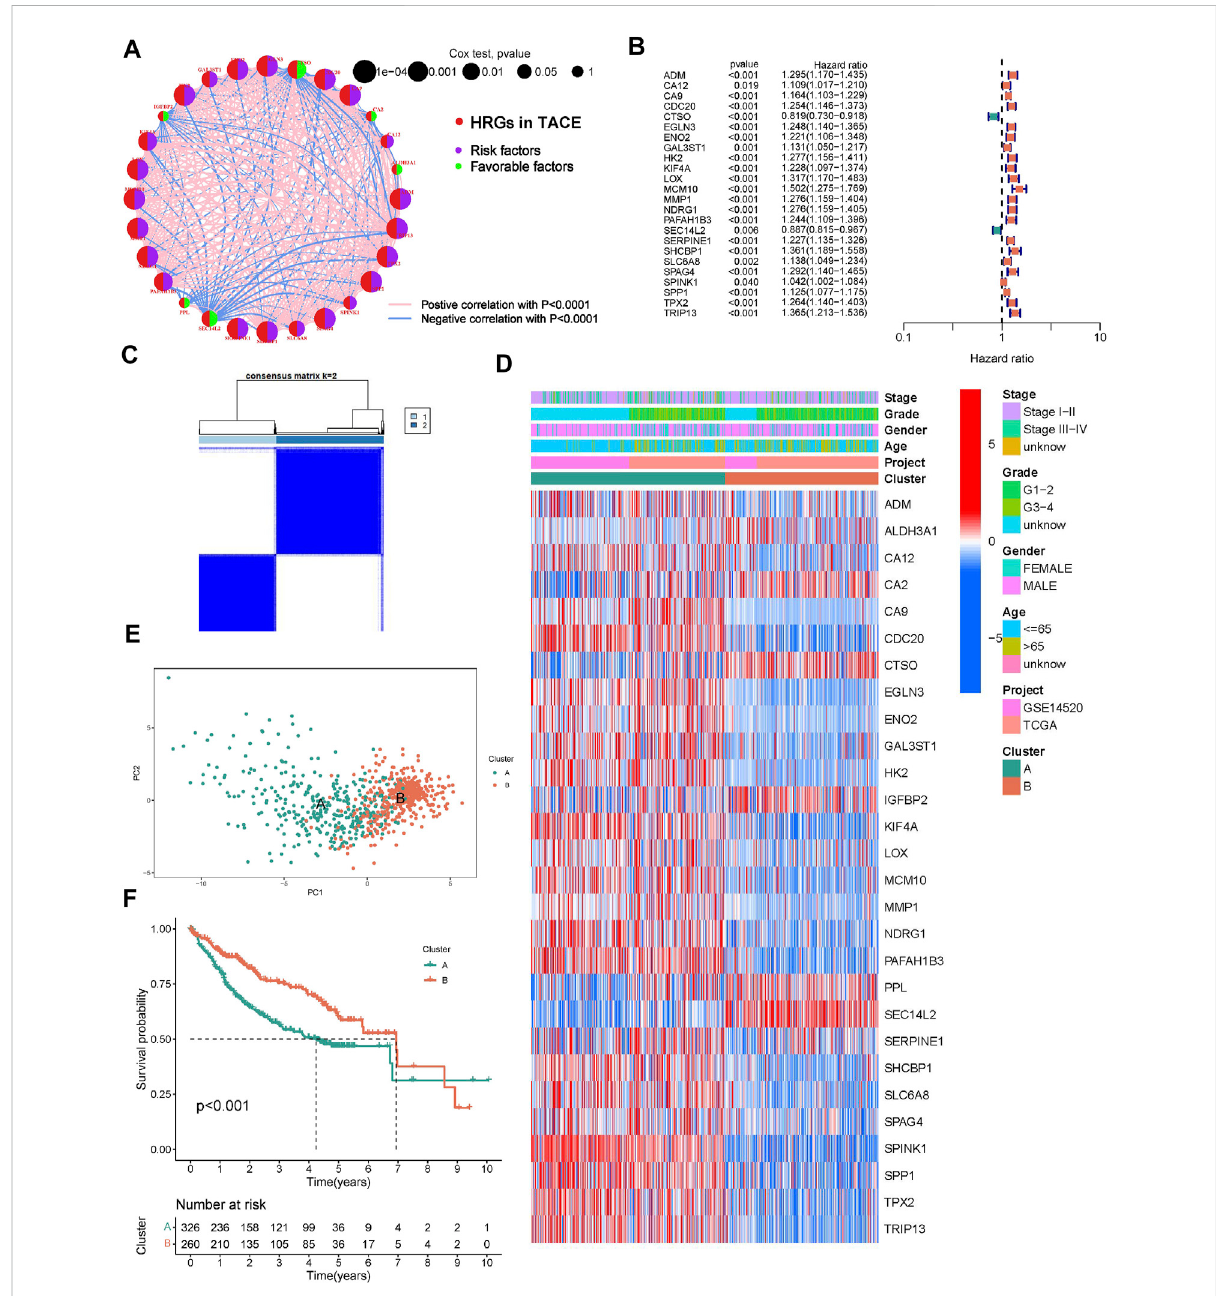
FIGURE 2 Molecular subtypes based on HRGTs. (A) The network of HRGTs described the combined interactions and prognostic signi fi cance. (B) A forest plot showed 24 HRGTs were indicative of prognostic signi fi cance. (C) The classi fi cation was optimal when the k value = 2. (D) Heat map of distribution of clinicopathological characteristics and molecular subtypes based on HRGTs. (E) PCA plot revealed that the two molecular subtypes had a relative discrete features. (F) Kaplan-Meier analysis of overall survival time in different molecular